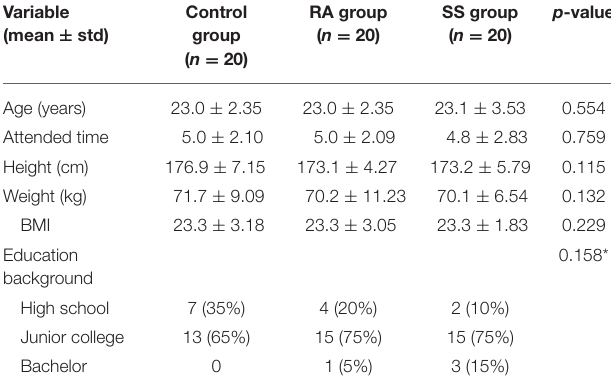
TABLE 1 | Demographic